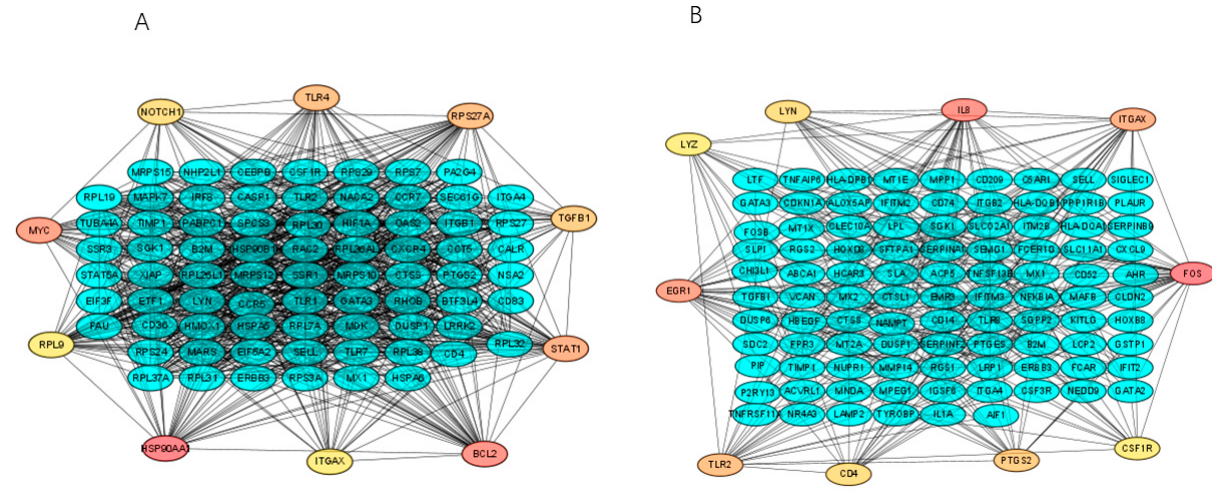
Figure 3. ( A ) Protein–protein interaction in slow freezing group after GSEA enrichment; ( B ) Protein– protein interaction in vitrification group after GSEA enrichment. protein interaction in vitrification group after GSEA